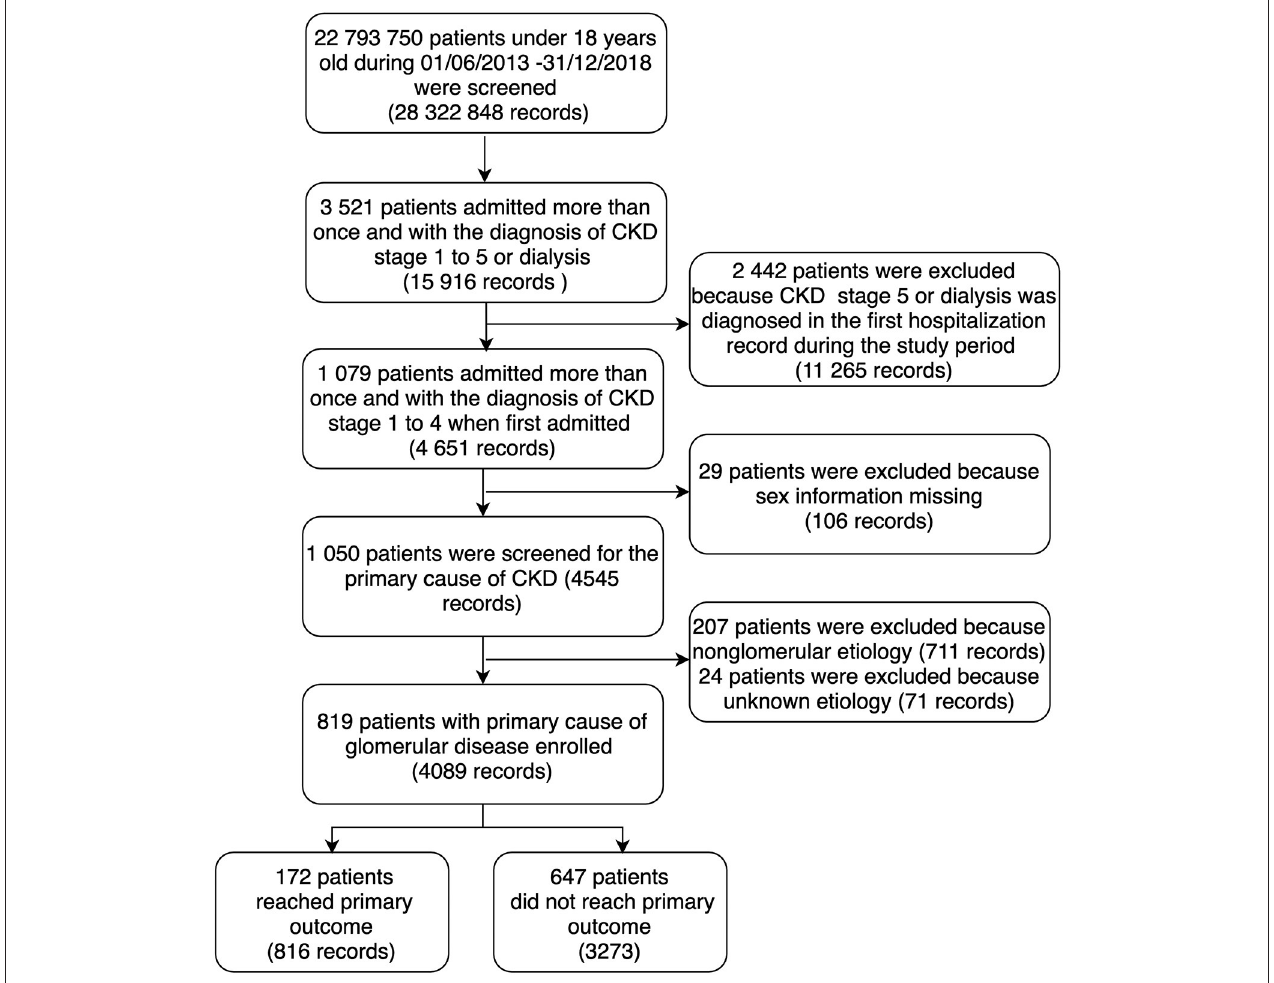
FIGURE 1 | The procedure of study population